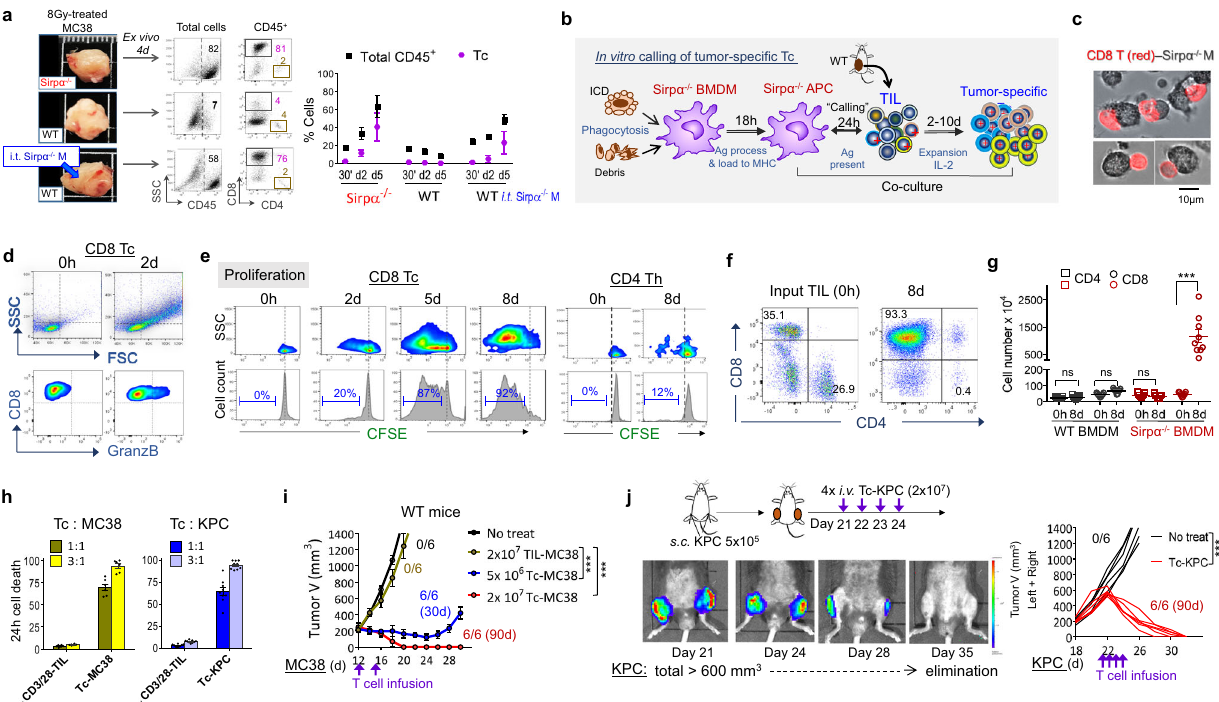
Fig. 6 Phagocytic Sirp α − / − macrophages function as APC and activate tumor-speci fi c Tc. a After IR (8 Gy), MC38 tumors (~300 mm 3 ) were excised, digested, and cultured ex vivo; some tumors from WT mice were i.t . injected with 3 × 10 6 Sirp α − / − BMDMs prior to cutting and culture. Single-cell suspensions were prepared at indicated time-points and analyzed for Tc and Th in CD45 + population. Data are representative of three independent experiments. n = 9 mice in each group. Each tumor was tested in triplicate. Data are presented as mean ± 95% con fi dence interval. b Experimental scheme of in vitro expansion of tumor-speci fi c Tc from TILs by tumor-phagocytosed Sirp α − / − BMDMs. c Images of Tc (red, CD8 staining) from MC38 tumor- forming conjugates with MC38 antigen-loaded Sirp α − / − BMDMs (gray). Data represent three independent experiments. d – g Speci fi c activation of Tc by tumor antigen-loaded Sirp α − / − BMDMs. Activation of Tc after 2 – 8 days of coculture of TILs with tumor antigen-loaded Sirp α − / − BMDMs was evident by cell size enlargement ( d ) and robust proliferation ( e – g ) of Tc but not Th. FACS data ( d – f ) are representative of three independent experiments coculturing MC38 TIL with MC38 tumor antigen-loaded Sirp α − / − BMDMs. Number of T cells before and after coculture ( g ) was presented as mean ± SEM and represent three independent experiments. WT BMDMs were used as control. n = 9 in each group. *** P < 0.001. For each experiment, TILs from 3 to 4 mice were pooled for expansion. Similar results were also observed in experiments coculturing KPC TIL with KPC tumor antigen-loaded Sirp α − / − BMDMs. h Tumoricidal activity of Tc expanded by M38- or KPC-loaded Sirp α − / − BMDMs compared to respective TILs nonspeci fi cally expanded by α CD3/CD28. Expanded Tc or TILs were added into MC38 or KPC cell culture at indicated effector:target ratios for 24 h. Experiments were performed in triplicate and data from three independent experiments are presented as mean ± SEM. For the testing killing of MC38 cells, n = 6 per group. For the testing killing of KPC cells, n = 9 per group. i , j Adoptive T-cell therapy testing Tc-MC38 and Tc-KPC tumoricidal activity in vivo. WT mice bearing MC38 ( i ) or KPC ( j ) tumors received Tc-MC38 or Tc-KPC, or the same number of α CD3/CD28-expanded TILs at indicated time points. Tumor volume and animal survival were monitored for 90 days post-treatment. Data from two independent experiments (3 mice/group in each experiment) are presented as mean ± SEM ( i ) or individual tumor volume ( j ). *** P < 0.001. P values were calculated by one-way ANOVA with Tukey ’ s post hoc test ( g , h , i , and j ). Source data are provided as a Source Data fi (Fig. 6e). Despite that the initial TILs comprised both Tc and Th cells, Sirp α − / − BMDMs exclusively induced robust proliferation of Tc but not Th cells, a phenomenon mirroring tumor-speci fi c Tc expansion in irradiated Sirp α − / − tumors in vivo. As shown in Fig. 6f – g, after 8 days of expansion in the presence of IL-2, large numbers of Tc were obtained. In vitro cytotoxicity assays ascertained the high cytotoxicity of Sirp α − / − BMDM-expanded Tc, which induced rapid cancer cell death (Fig. 6h, Supplementary Movies 2 and 3) at low effector: target ratios (1 – 3:1). Interestingly, these expanded Tc comprised only a small fraction (<5%) of clones that were reactive toward the tumor-speci fi c antigen p15E (Supplementary Fig. 9d), suggesting that the tumor-speci fi c Tc population comprised other tumor-reactive clones that recognized other tumor-speci fi c antigens. We next assessed the functional capacity of these Tc to eliminate tumors in vivo. In these experiments, Sirp α − / − BMDM- expanded Tc speci fi c for MC38 or KPC (termed Tc-MC38 or Tc-KPC) were i.v. administered to WT mice bearing the same